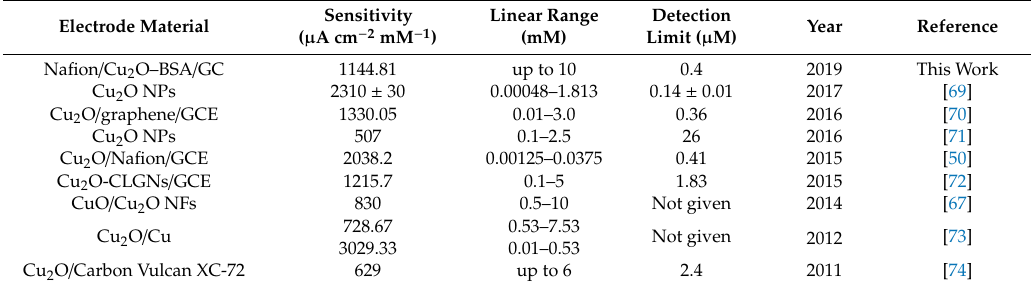
Table 1. Comparison of sensing behavior of Nafion / Cu 2 O–BSA / GCE with other reported Cu 2 O or CuO-based non-enzymatic glucose sensors.